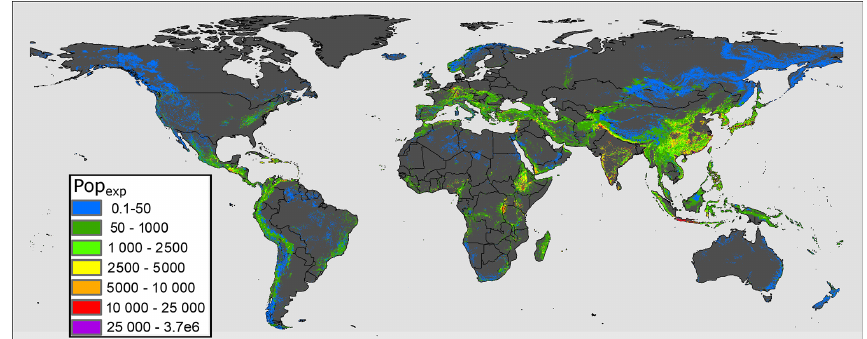
Figure 1. Global modelled population exposure to landslides (Pop exp ). Since the distribution of high-exposure areas is highly localised, we have binned the data to highlight differences at lower exposure levels more clearly. The source for the country boundaries is UIA World Countries Boundaries, ArcGIS Hub, https://hub.arcgis.com/datasets/ (last access: 16 August